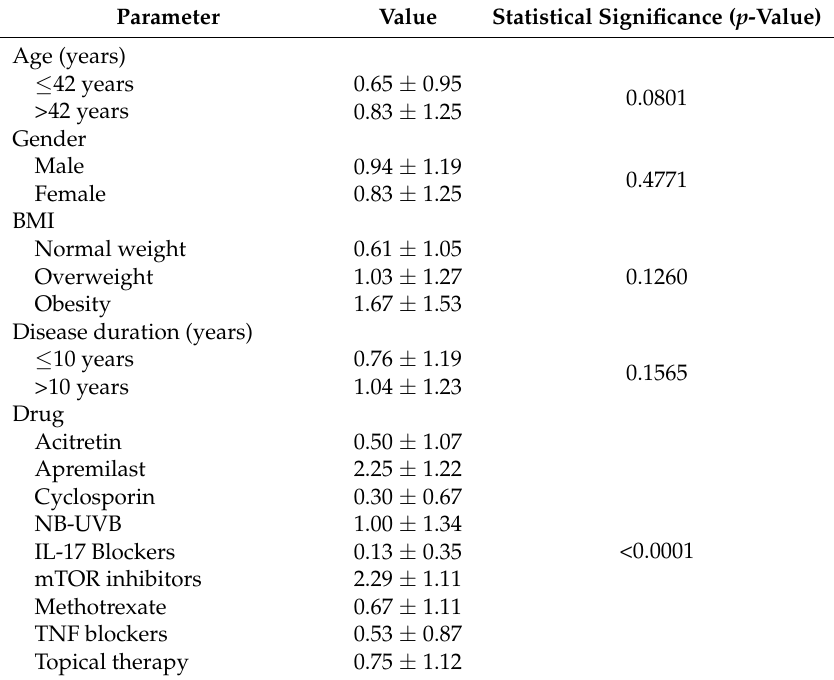
Figure 1. Change in the “Psoriasis Area and Severity Index” (PASI) score before and after the Ramadan fasting. A statistically significant correlation could be found between the PASI score before the fasting and BMI (Pearson’s r = 0.2 [95% CI 0.0 to 0.4], p = 0.0218; Spearman's rho = 0.2 [95% CI 0.1 to 0.4], p = 0.0148). Interestingly, this correlation was not further significant between PASI after the fasting and BMI (Pearson’s r = 0.1 [95% CI −0.1 to 0.3], p = 0.1415; Spearman’s rho = 0.2 [95% CI −0.0 to 0.3], p = 0.1047). The change in the PASI score before and after the Ramadan fasting (delta PASI) correlated, instead, with BMI (Pearson’s r = 0.2 [95% CI 0.0 to 0.4], p = 0.0324; Spearman’s rho = 0.2 [95% CI 0.0 to 0.4], p = 0.0449). At the univariate analysis (presented in Table 2), only the type of drug received influenced significantly the change in the PASI score before and after the Ramadan fasting ( p < 0.0001), with apremilast and mTOR inhibitors reporting the largest changes, whereas age as a predictor resulted statistically borderline ( p = 0.0801). Table 2. Univariate analysis of the determinants of change in the Psoriasis Area Severity Index (PASI) score before and after the Ramadan fasting.